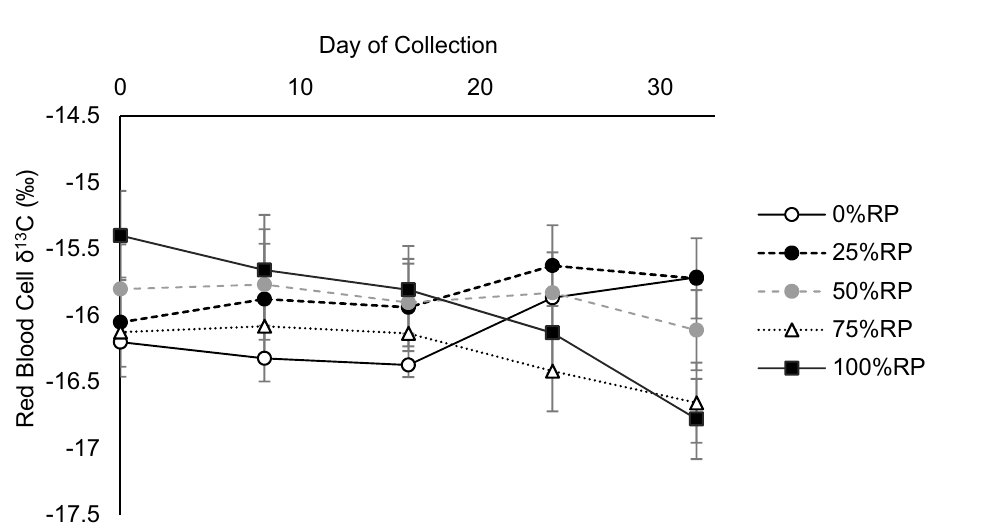
Figure 2. δ 13 C ( a ) and δ 15 N ( b ) plasma of beef cattle consuming increasing proportions of rhizoma peanut (RP) hay in bahiagrass hay. Day of collection represents the number of days after dietary change. Asterisk indicates treatment differences ( P ≤ 0.05) exist within the day of collection.